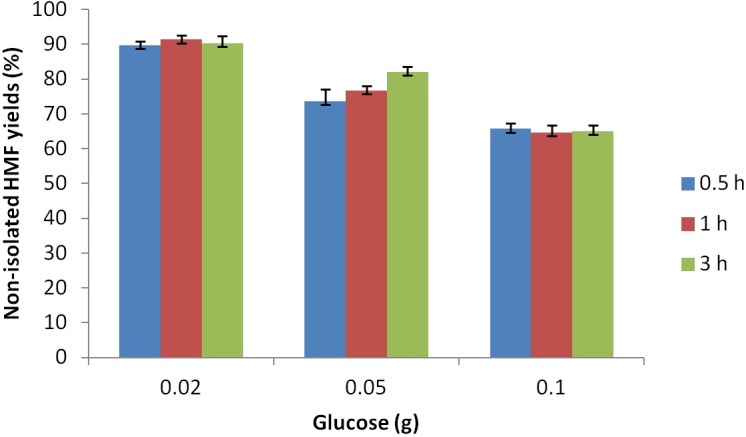
HMF yield from glucose as a function of substrate loading at 120°C.0.7 g [C4C1im]Cl, 7 mol% CrCl3·6H2O catalyst. Reported yields are non-isolated. The lines are included solely as an aid to guide the eye.